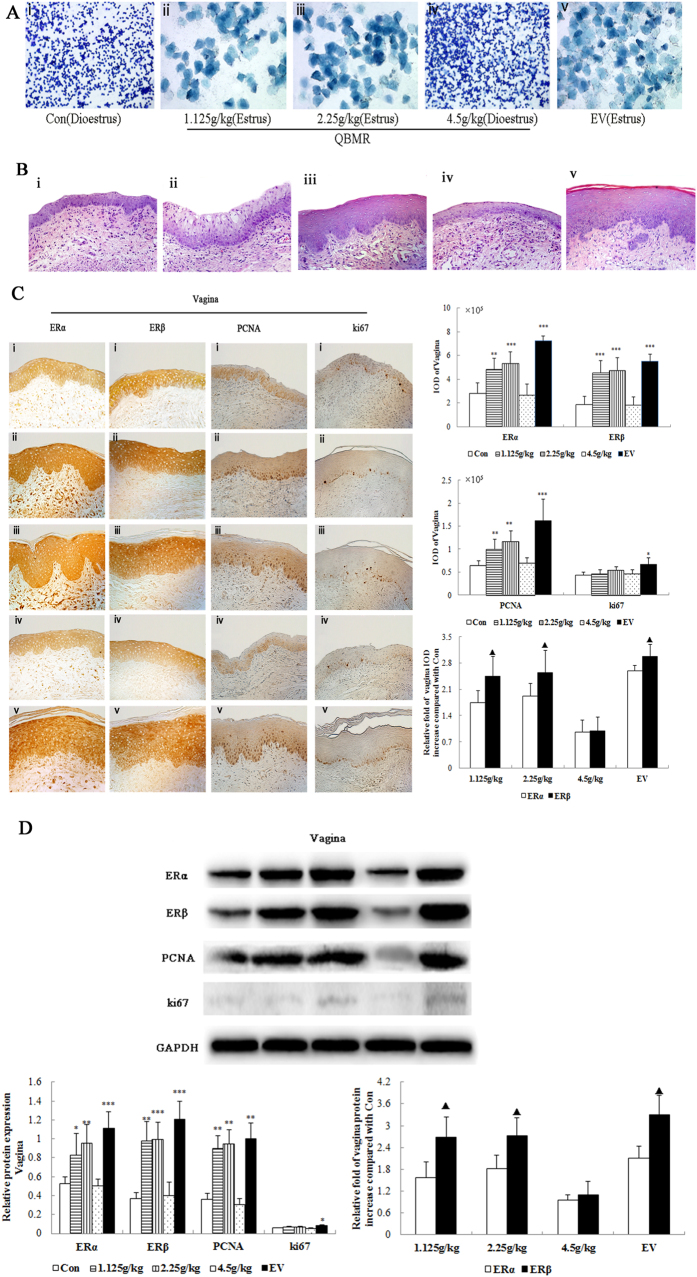
The effects of QiBaoMeiRan formula (QBMR) on vagina.Data are the mean ± standard deviation (SD) of samples from 10 mice. P values are based on the results of a one-way analysis of variance (ANOVA) comparing the treatment group with untreated immature mice. ***p < 0.001 **p < 0.01 and *p < 0.05, compared to the control group. #p < 0.05, compared to QBMR 1.125 g/kg group. (▲) p < 0.05, compared with ERα protein relative increase to Control. (A) The effects of QBMR on the estrus cycle. Vaginal epithelial cell smears were taken at the seventh day from immature untreated mice (i), mice treated with QBMR 1.125 g/kg (ii), mice treated with QBMR 2.25 g/kg(iii), mice treated with QBMR 4.5 g/kg (iv), and mice treated with estradiol valerate (EV) (v). (B) The effects of QBMR treatment on vagina histology in immature mice. (C) The effects of QBMR treatment on the expression of ERα, ERβ, and PCNA in the vagina. Representative photomicrographs taken at 400× magnification of the uterus, ERα and ERβ expression in the vagina, 100× magnification of PCNA and ki-67 expression in the vagina sections from each treatment group are shown: (i) untreated immature mice, (ii) 1.125 g/kg, (iii) 2.25 g/kg, and (iv) 4.5 g/kg QBMR, and (v) EV. (D) The effects of QBMR formula on the protein expression levels of estrogen receptor (ER) α, ERβ, proliferating cell nuclear antigen (PCNA) and ki-67 in the vagina by western blot.